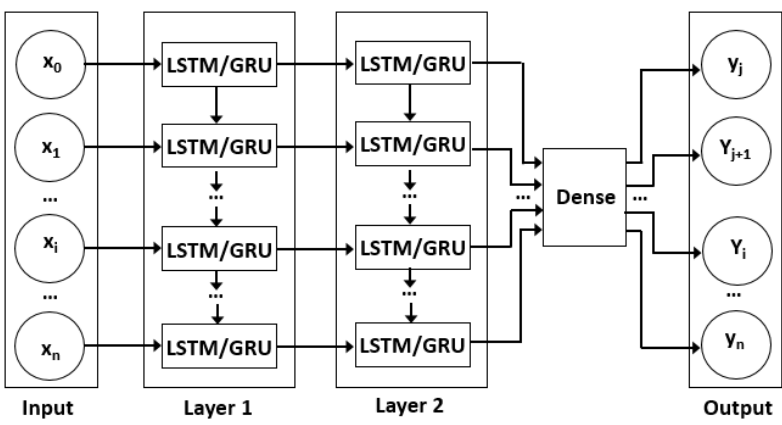
Figure 5. Stacked LSTMs and GRUs structure.